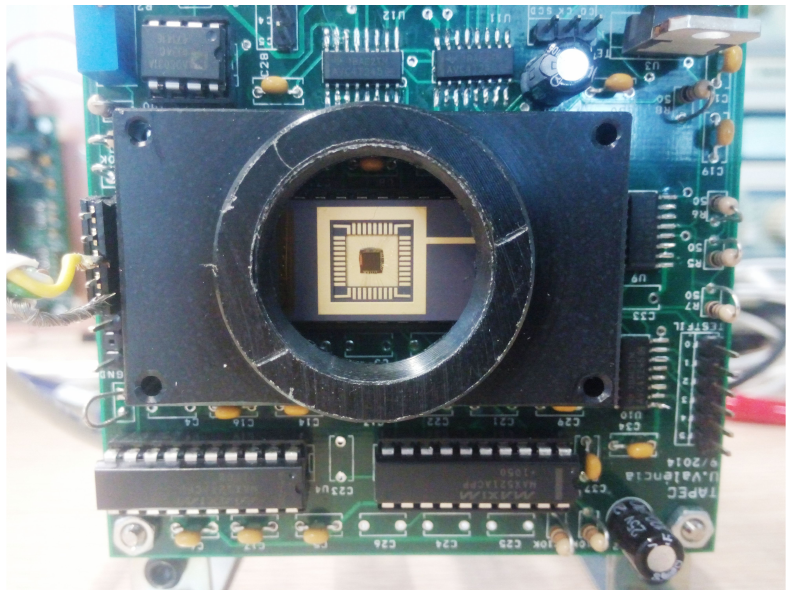
Figure 4. Details of the SCD sensor in the